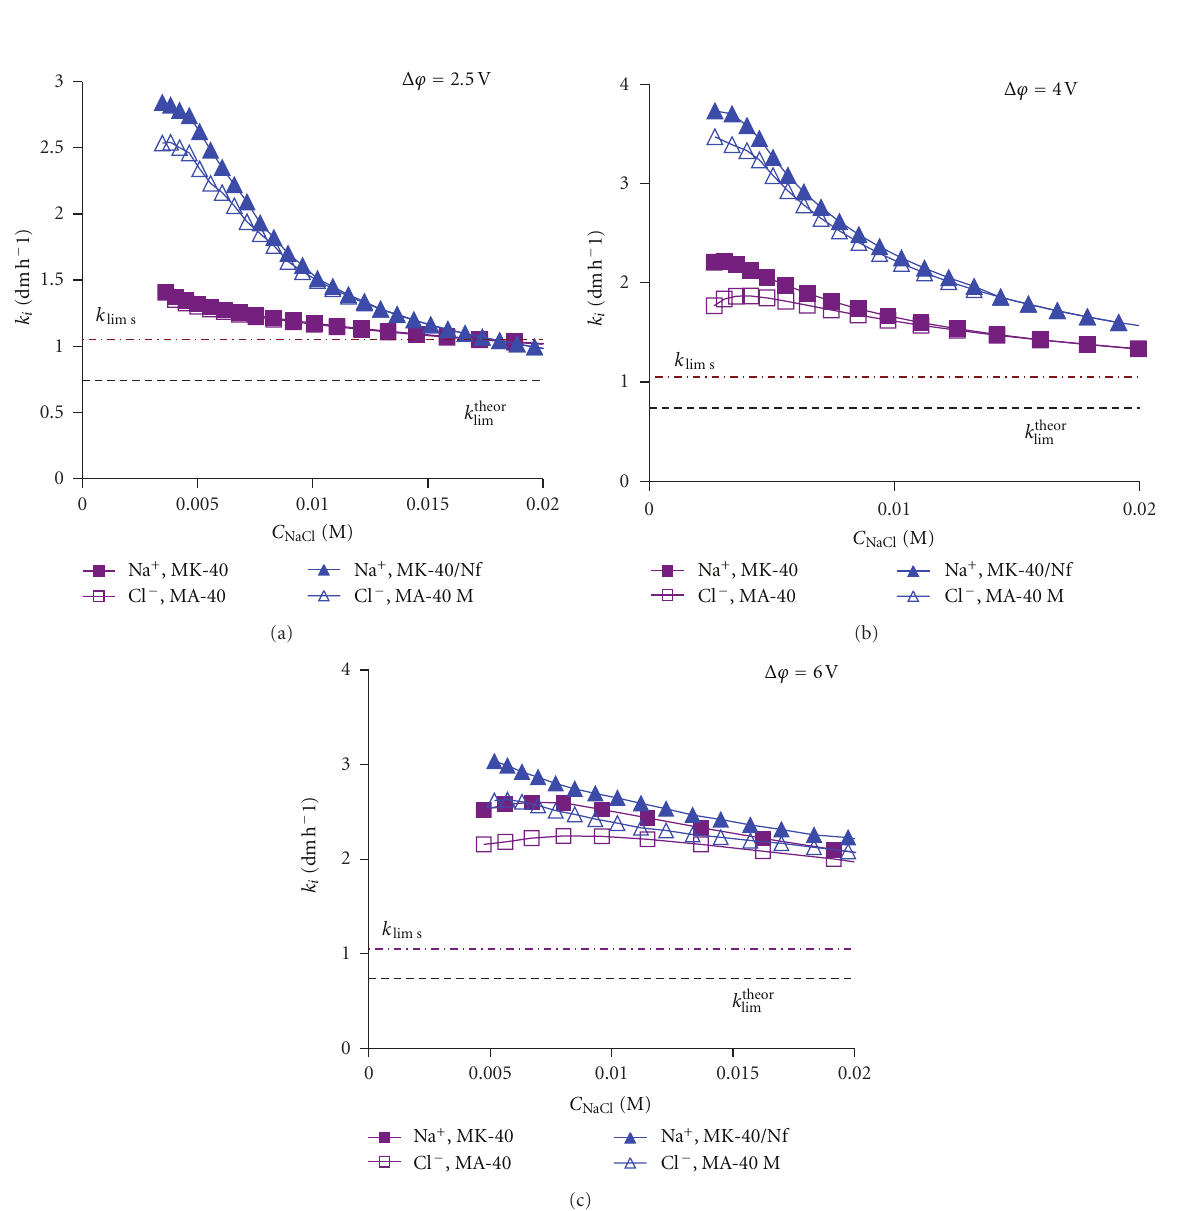
Figure 3: Concentration dependence of Na + mass-transfer coe ffi cients across MK-40 and MK-40/Nf cation-exchange membranes and Cl − across MA-40 and MA-40M anion-exchange membranes forming desalination channels in a cell shown in Figure 2 under di ff erent potential drops ( Δ ϕ ) per cell pair: 2.5V (a), 4.0V (b), and 6 V (c). The limiting mass-transfer coe ffi cient for the DC without spacer, k theor according to (7); the limiting mass-transfer coe ffi cient for DC with spacer, k lims , is evaluated as described in the